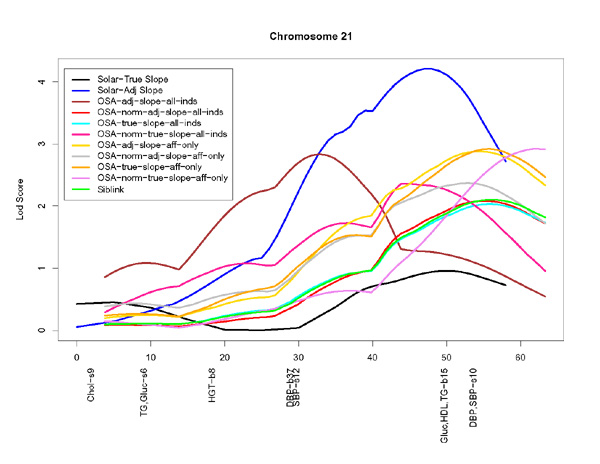
LOD score curves for linkage results on chromosome 21. The x-axis is in cM along with the location of genes on that chromosome. SOLAR curves are for the normalized SBP slopes. The SIBLINK curve shows the ASP LOD score for HBP.